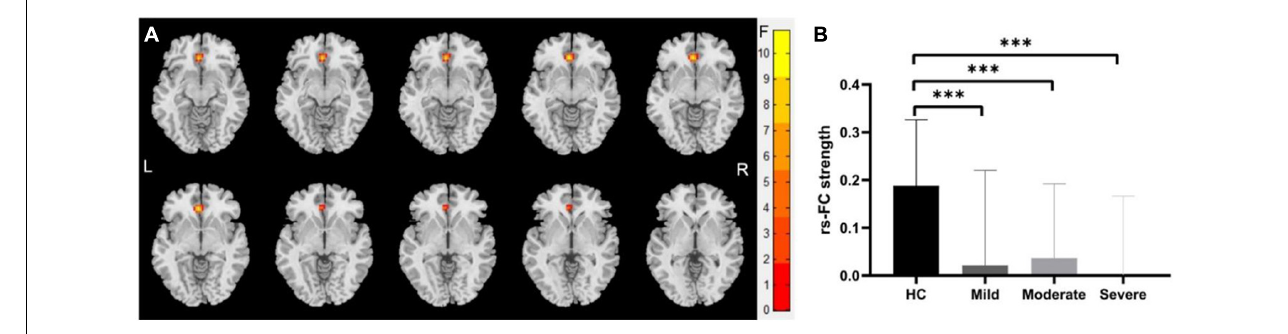
FIGURE 3 | Differences of functional connectivity (FC) between groups at the right-sided cerebellum lobule VI—whole brain level. (A) Significant differences were observed between patients with WMHs and healthy controls (HC) in the FC between the right-sided cerebellum lobule VI with the left anterior cingulate gyri (voxel size: 39; peak MNI coordinates: x = –3, y = 33, and z = –6; GRF for voxel levels at P < 0.001 and cluster at P < 0.05). (B) The functional connectivity of the right-sided cerebellum lobule VI with the left anterior cingulate gyri was significantly decreased in patients with WMHs. ∗∗∗ P <